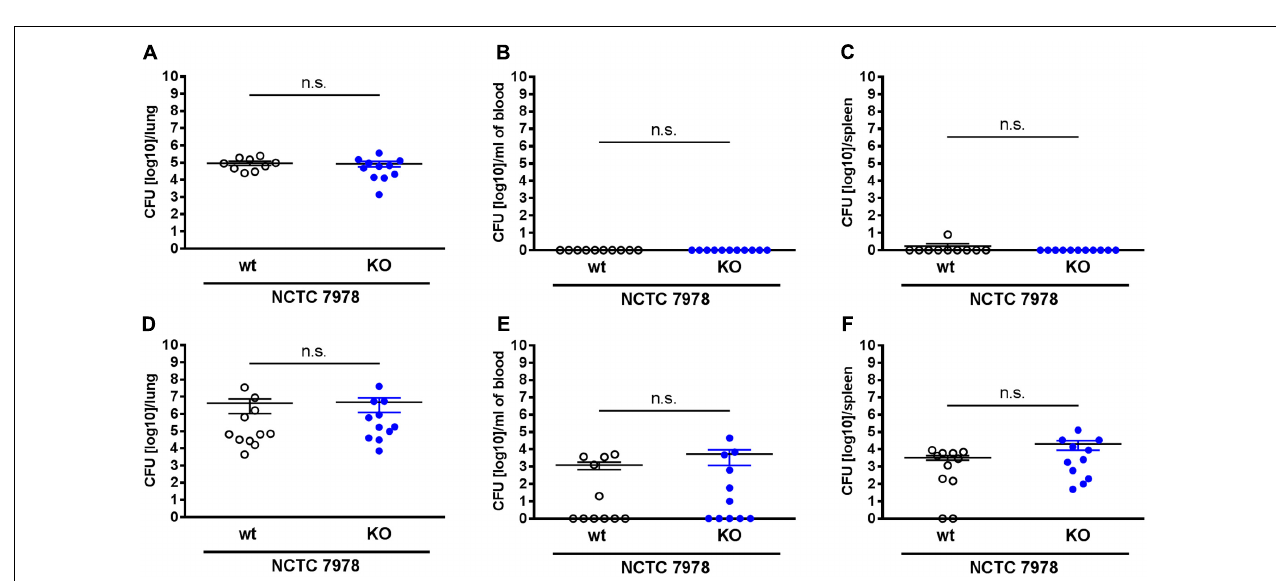
FIGURE 2 | The loss of PGLYRP3 did not affect the bacterial load. Mice were infected intranasally with 10 5 CFUs of the S . pneumoniae strain NCTC 7978 per mouse. The lungs (A,D) , the blood (B,E) and the spleens (C,F) were analyzed 12 h (A–C) and 48 h (D–F) after infection for the bacterial load in wt and PGLYRP3KO mice. Ten to eleven animals per group (mean ± SEM); Mann–Whitney U test: ns, not significant.